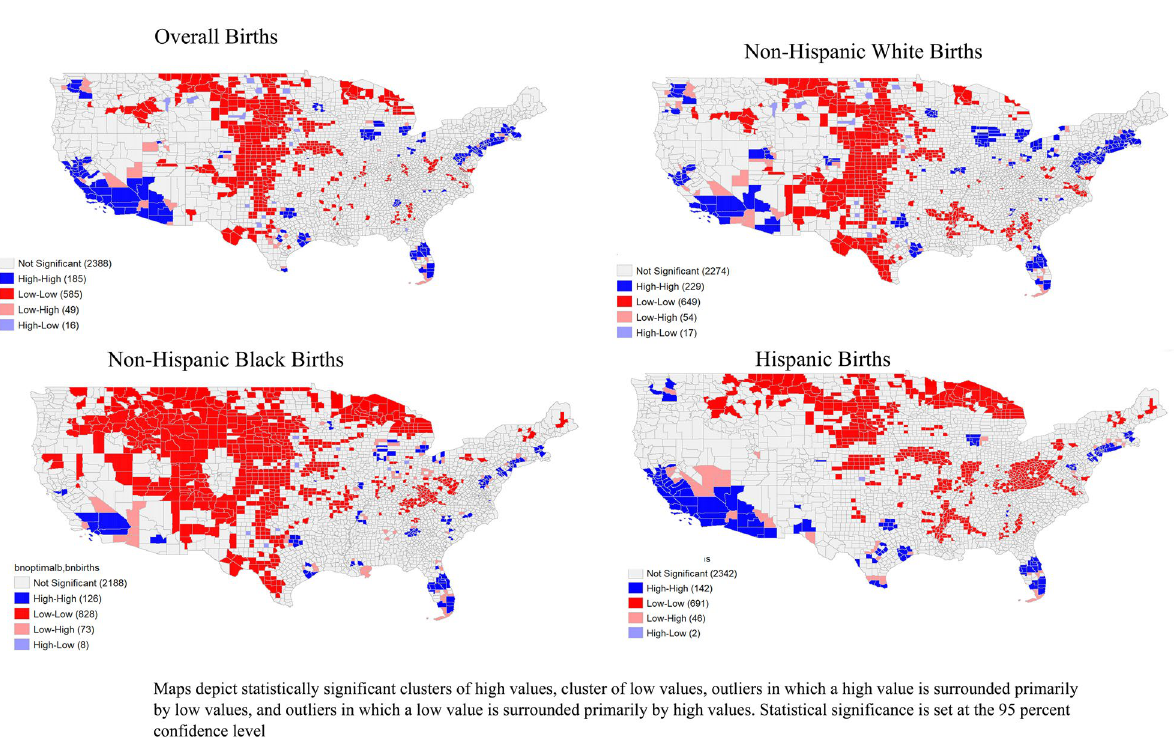
Figure 2. Overall and race-specific county-level local-indicators of spatial autocorrelation (LISA) cluster significance using raw rates of optimal births. Map generated in Geoda version 1.18.0.10 (https:// spati al. uchic ago. edu/